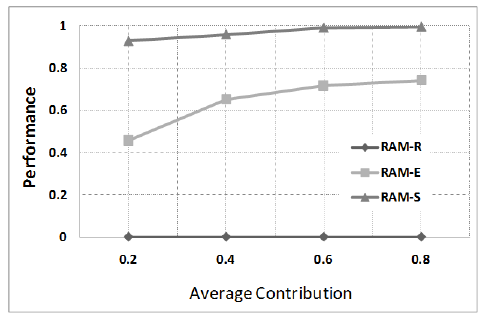
Fig. 4. Evaluation of the performance metric versus average value of individual contributions.